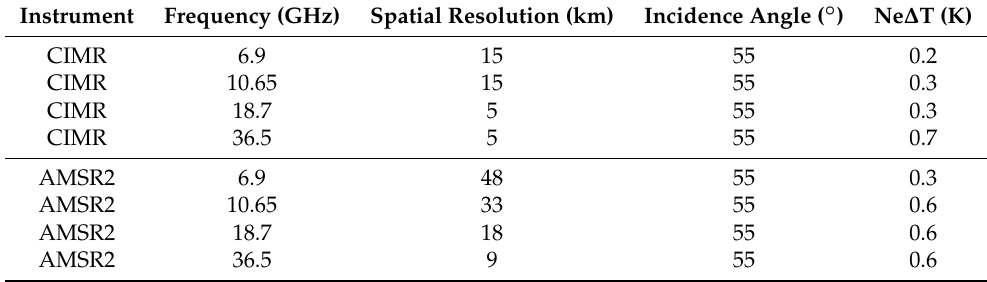
Table 1. The Copernicus Imaging Microwave Radiometer (CIMR) instrument specifications with a 7 m diameter antenna, as compared to the characteristics of the Advanced Microwave Scanning Radiometer 2 (AMSR2) current instrument, for their common frequencies used in this study. The central frequency, the spatial resolution, the incidence angle, as well as the instrument noise (Ne ∆ T) are indicated. Instrument Frequency (GHz) Spatial Resolution (km) Incidence Angle ( ◦